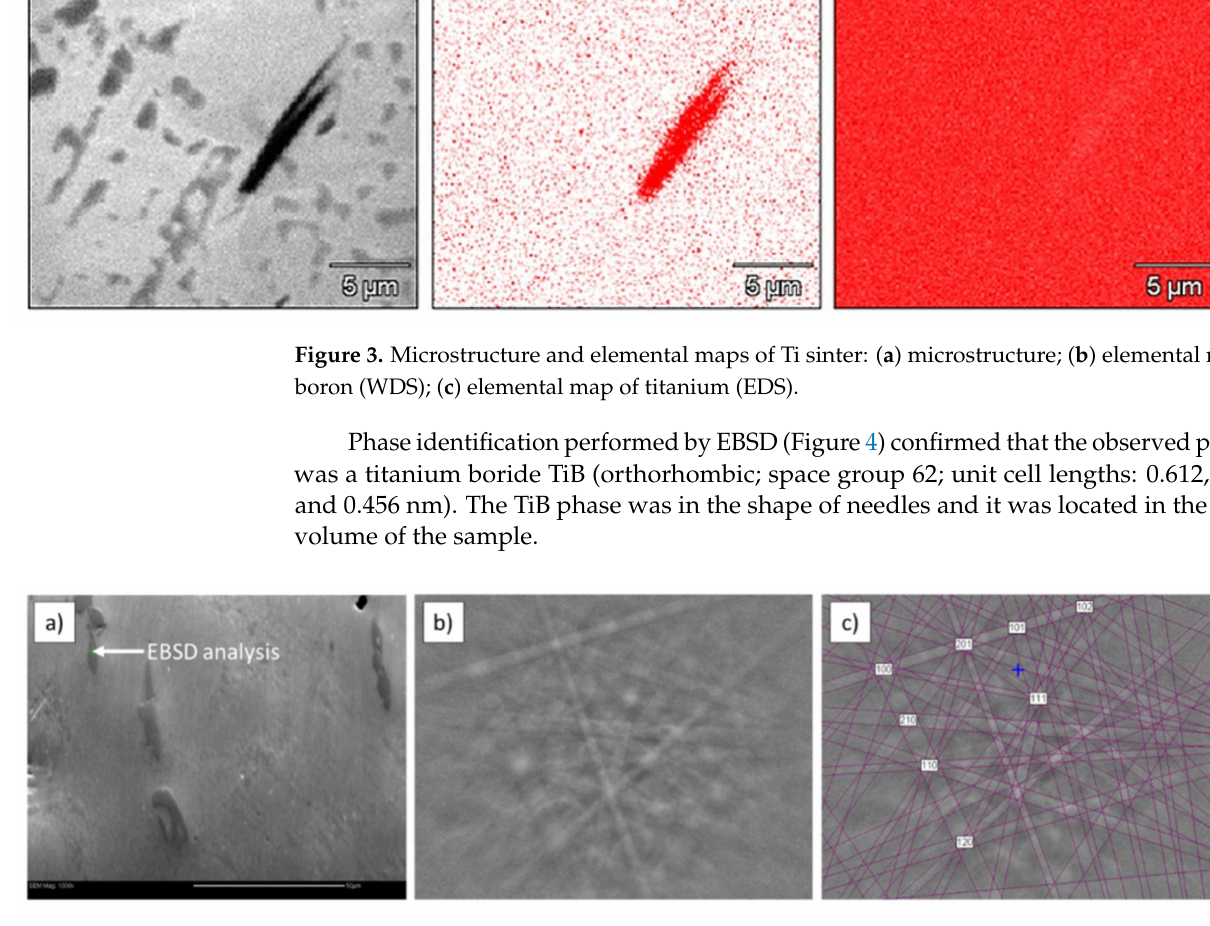
Figure 4. EBSD analysis of Ti sinter: ( a ) microstructure; ( b ) Kikuchi pattern of TiB phase; ( c ) indexed Kikuchi pattern of TiB